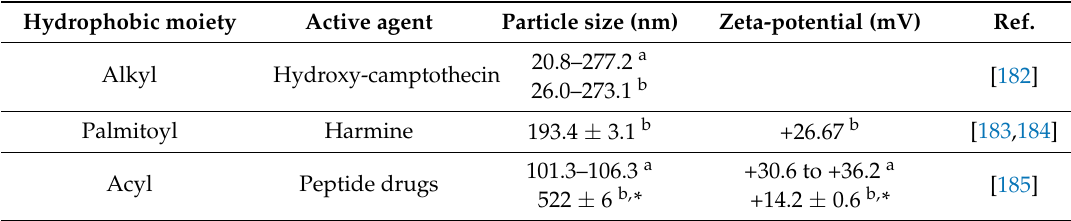
Table 8. Hydrophobically modified trimethyl